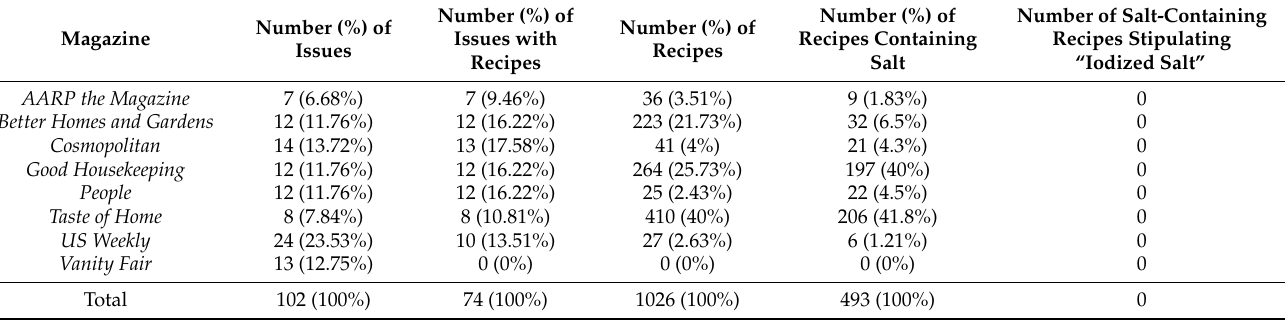
Table 2. Numbers of issues and recipes reviewed for inclusion of salt and iodized salt in the list of ingredients in magazines published between 2019 and